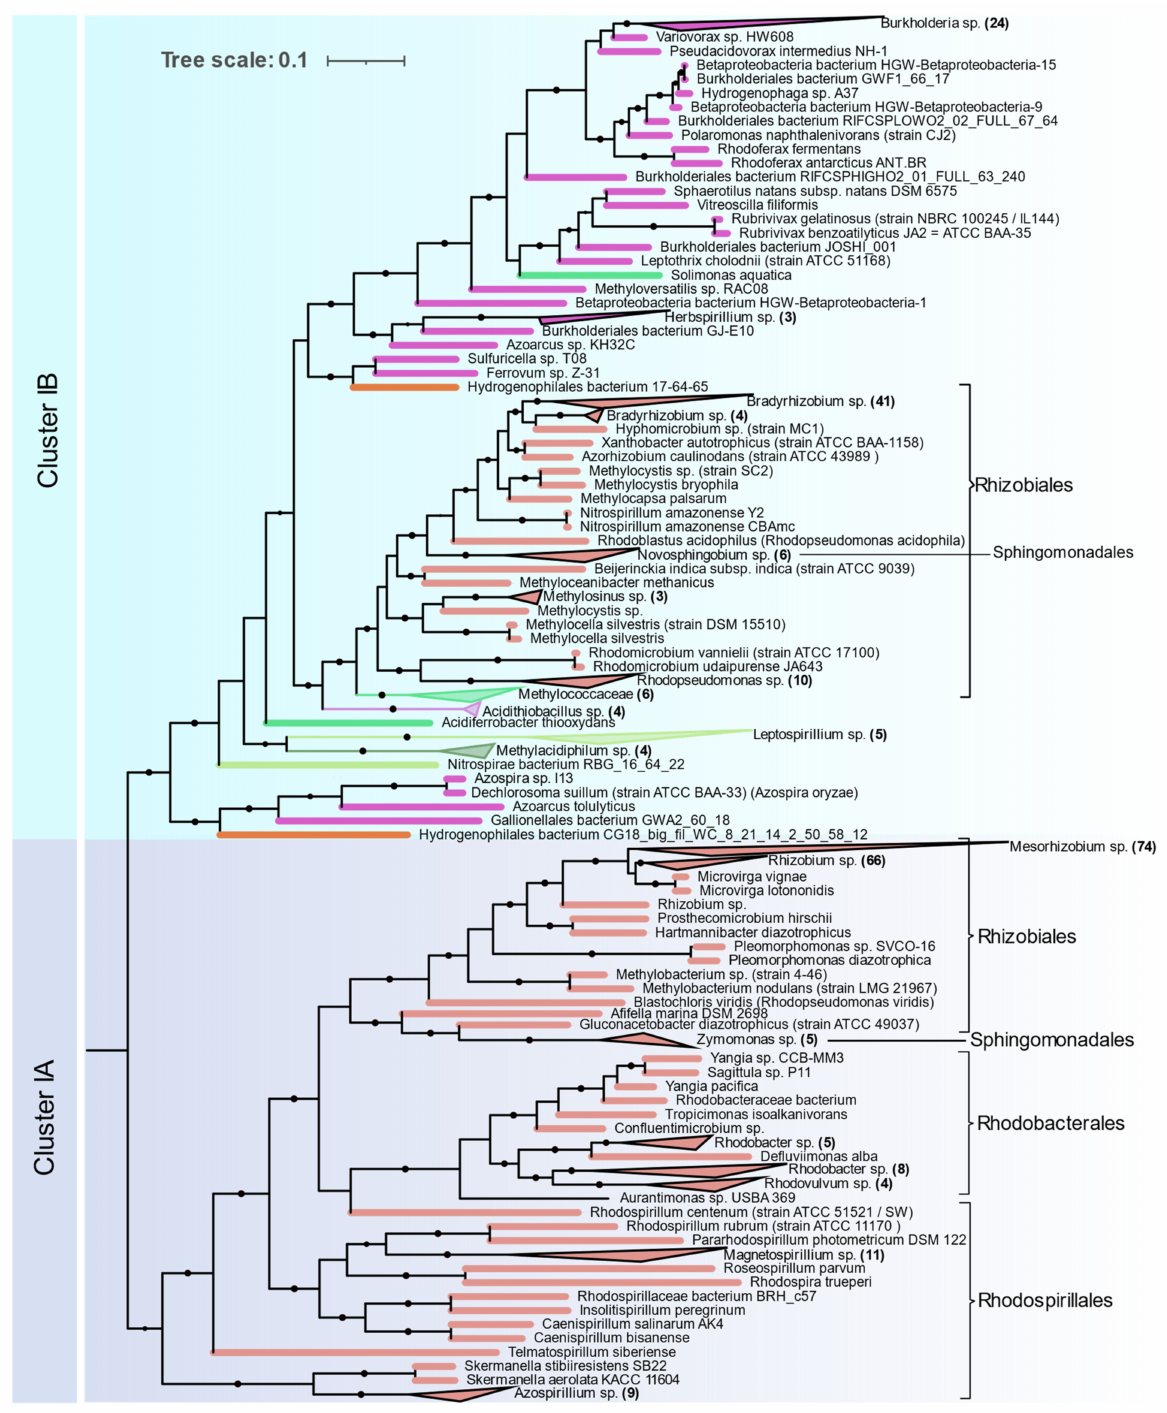
Figure 5. NifHDKENB Clusters IA and IB showing the phylogenetic relationship among Proteobacterias obtained by